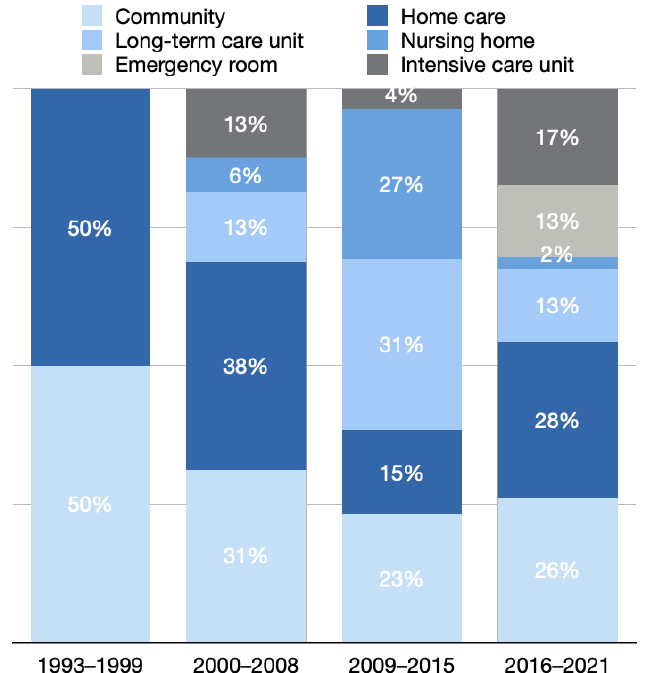
Figure 6. Distribution of fields of investigation in out-of-hospital settings in different periods.